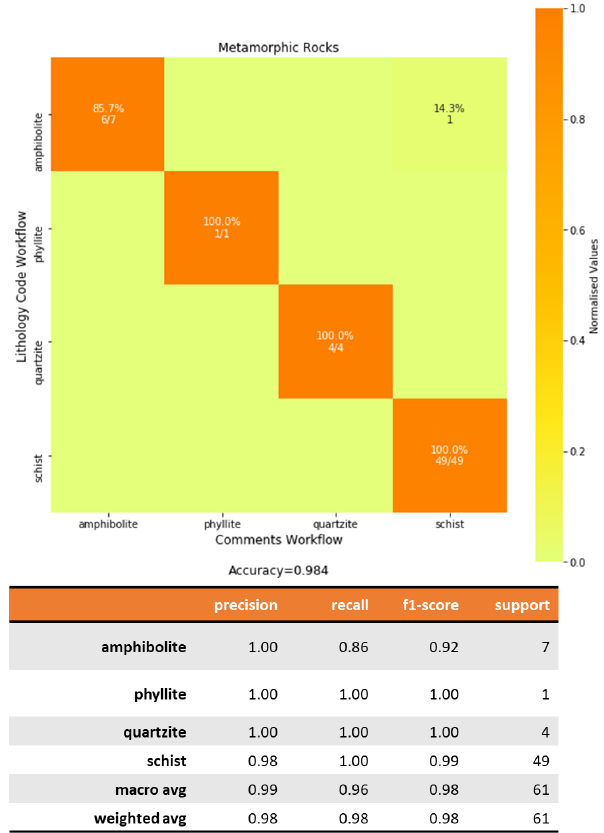
Figure 10. Confusion matrix for metamorphic rocks comparing the fuzzy string matching results from the Lithology Code work- flow (vertical axis) and Comments workflow (horizontal axis). The heatmap shows the values normalized to the support size to address the imbalance between classes. The values shown in the cells in- dicate the number of samples classified for the class. Empty cells indicate zero samples.